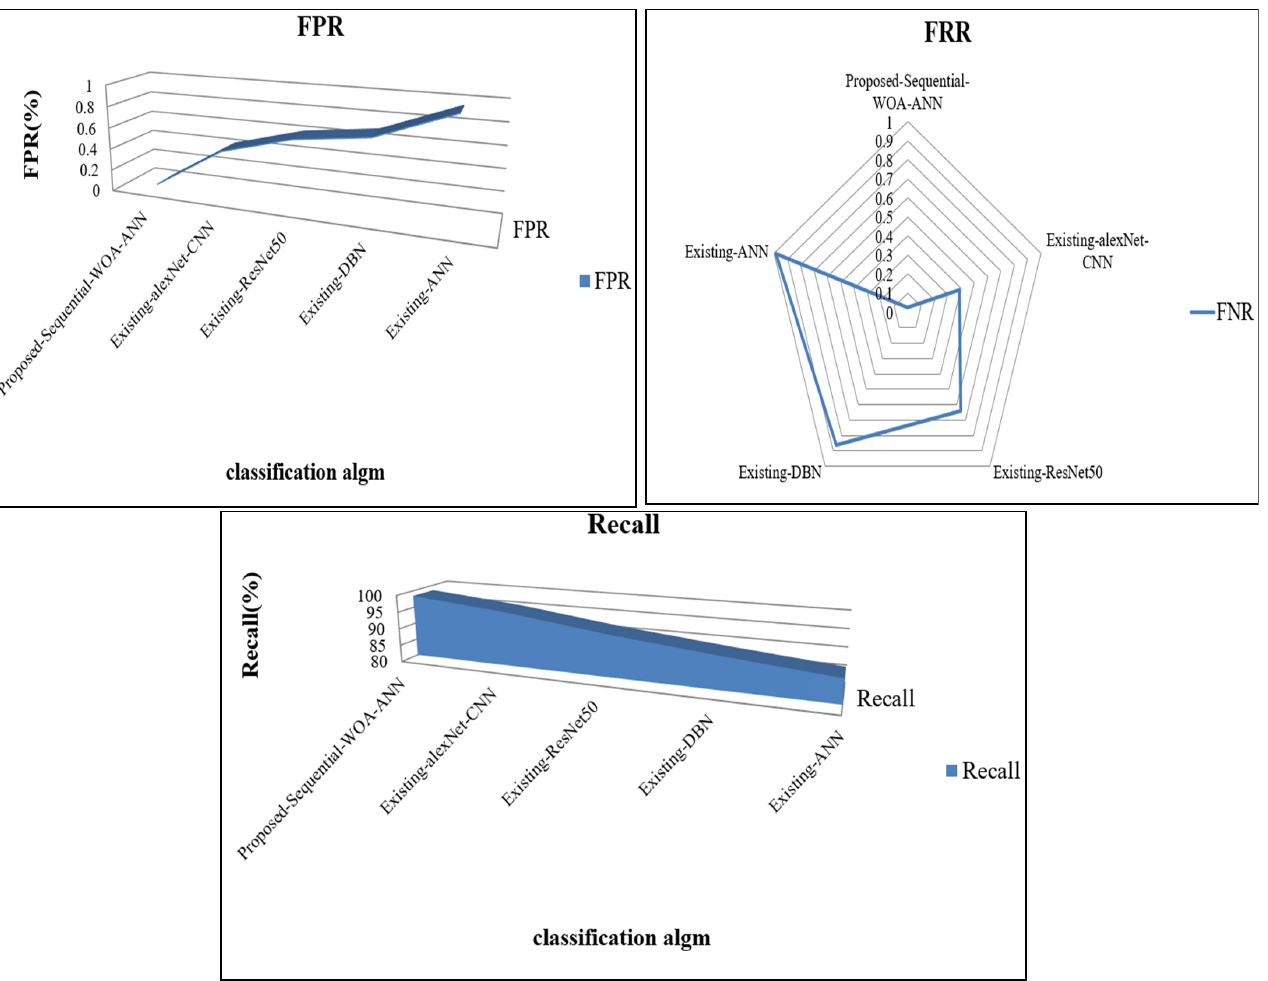
Figure 10. Graphical demonstration of classification metrics for sequential model architecture.